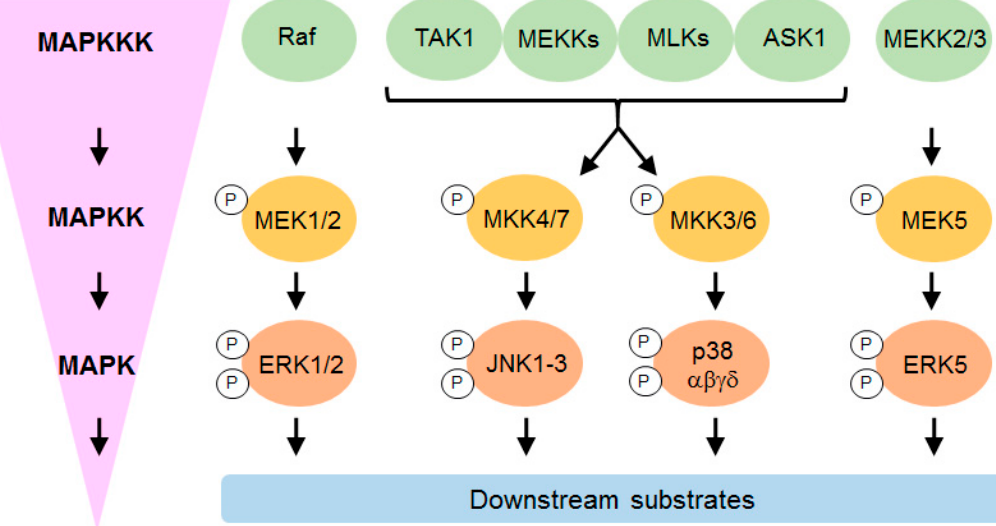
Figure 1. Canonical MAPK signaling. Schematic simplified representation of the different classical MAP kinase pathways in mammals. The mitogen-activated protein kinase (MAPK) pathways consist of a cascade of three kinases which phosphorylate (indicated by P) and activate each other sequentially. Mitogens, cytokines, and cellular stresses act as the stimulus to promote the activation of these MAPK pathways. MAPKs regulate cellular function by phosphorylating downstream substrates in the nucleus (e.g., transcription factors), cytosol, cytoskeleton, mitochondria and plasma membrane. MAPK: Mitogen-activated protein kinase; MAPKK: Mitogen-activated protein kinase kinase; MAPKKK: Mitogen-activated protein kinase kinase kinase.